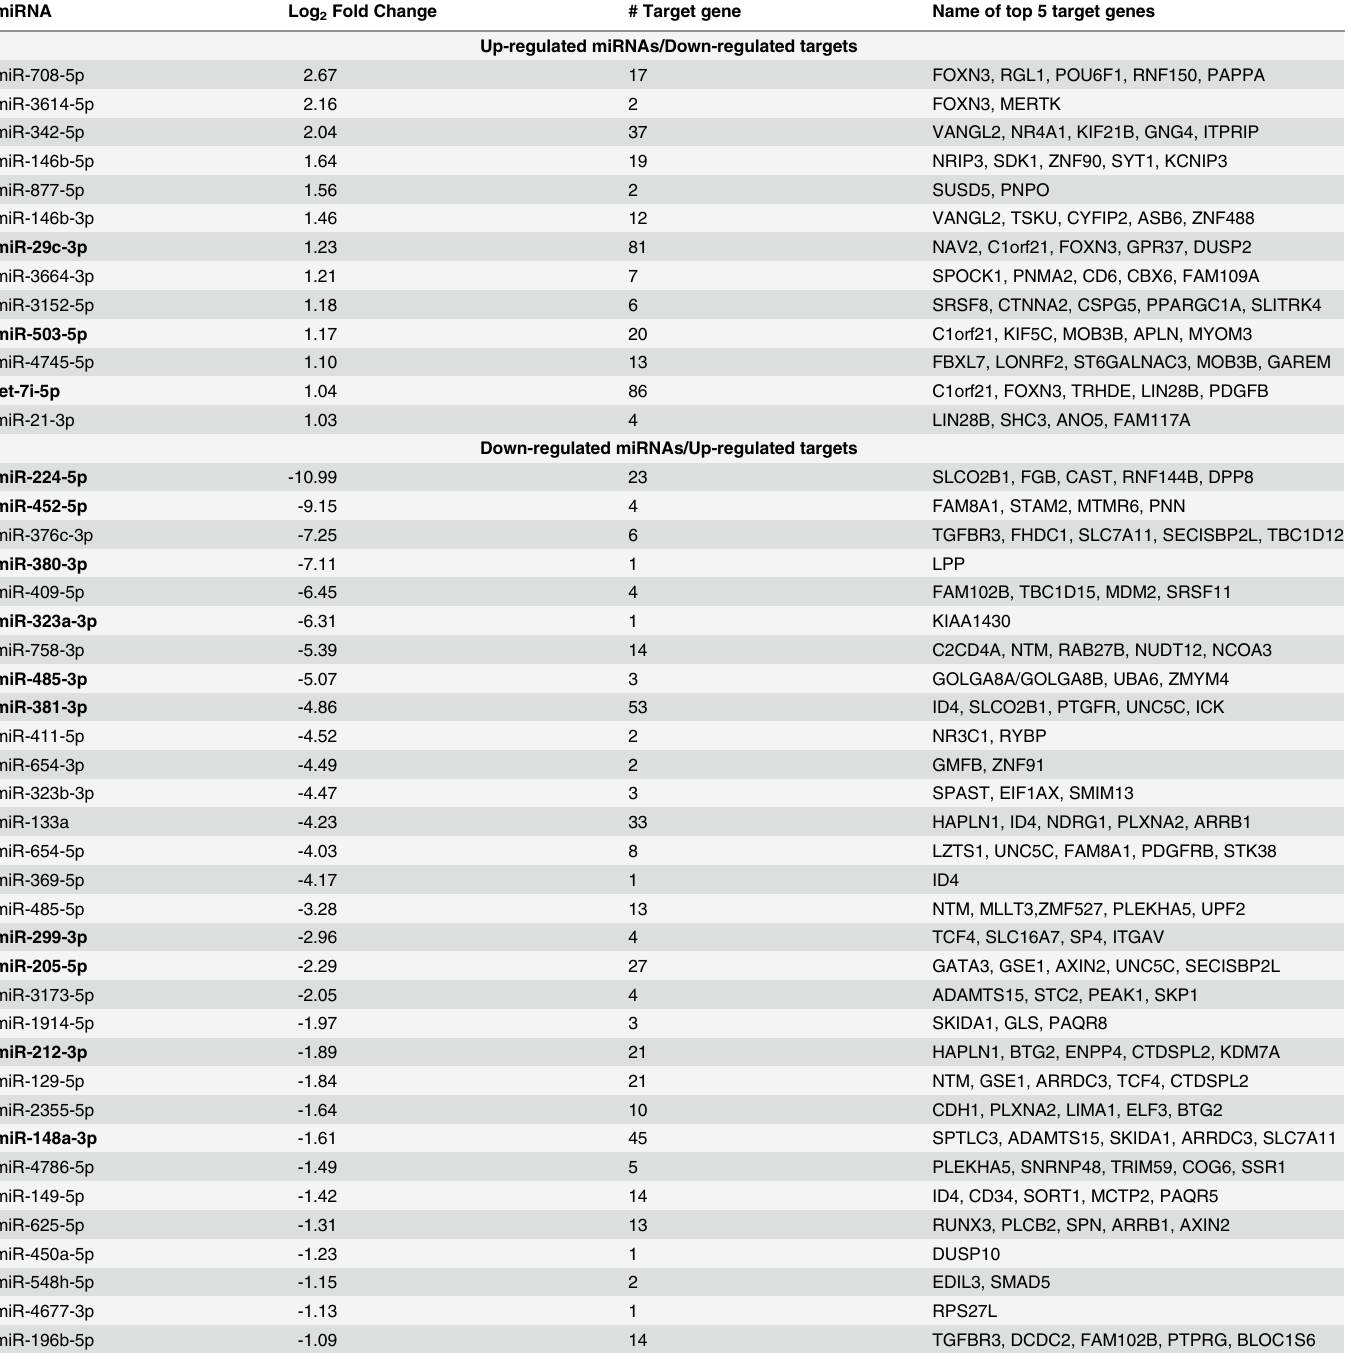
Table 2. Ingenuity analysis predicts inversely correlated miRNAs and mRNAs pairs.